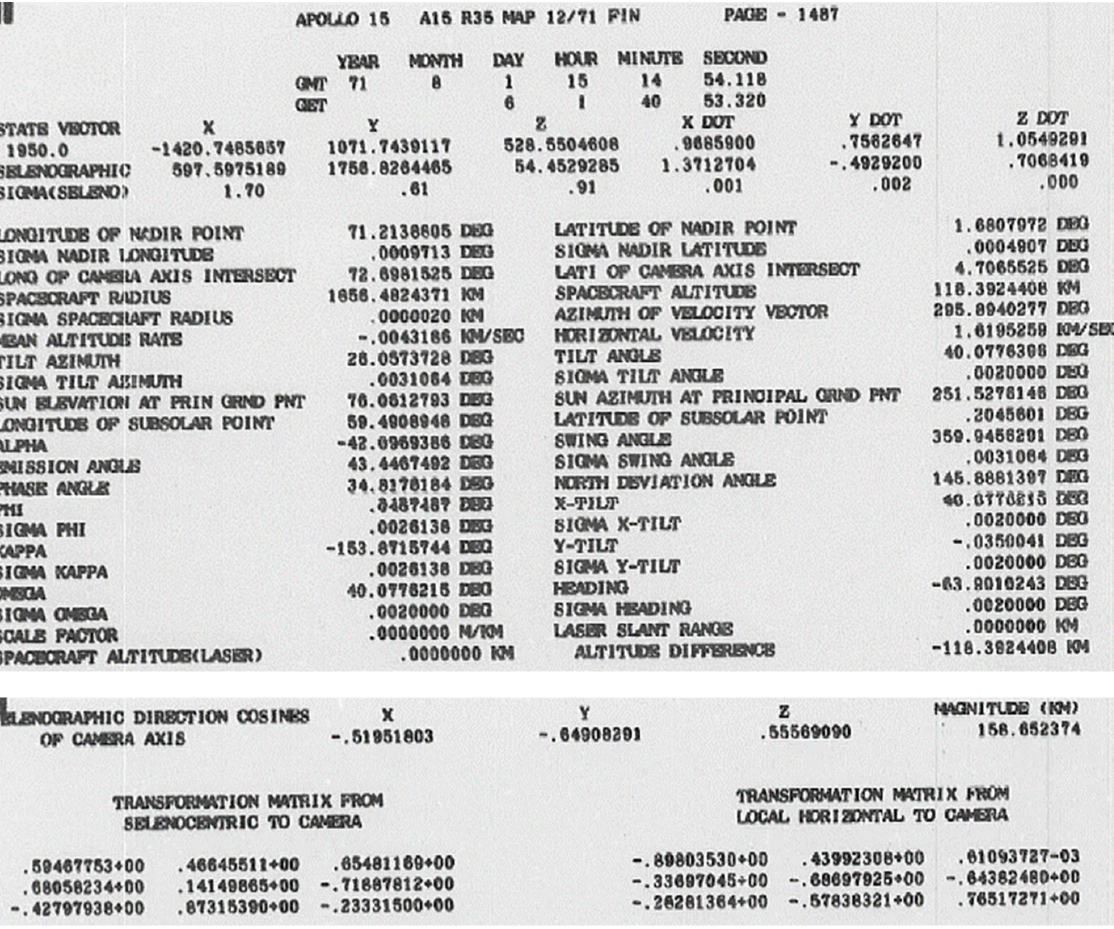
Figure 6: Support data pages for oblique image AS15-M-1487 (NASA).